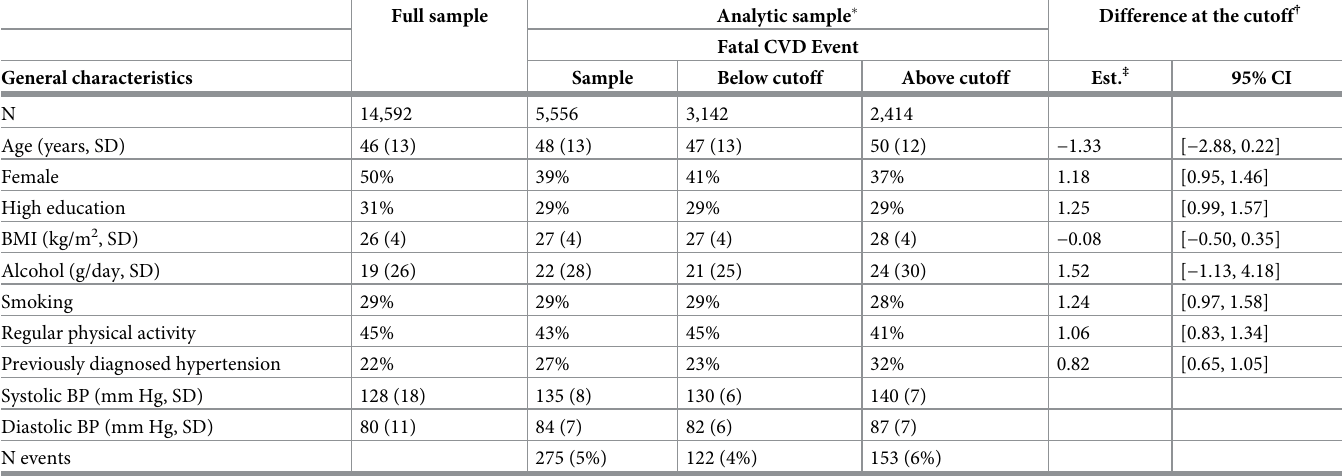
Table 1. Descriptive statistics of the analyzed